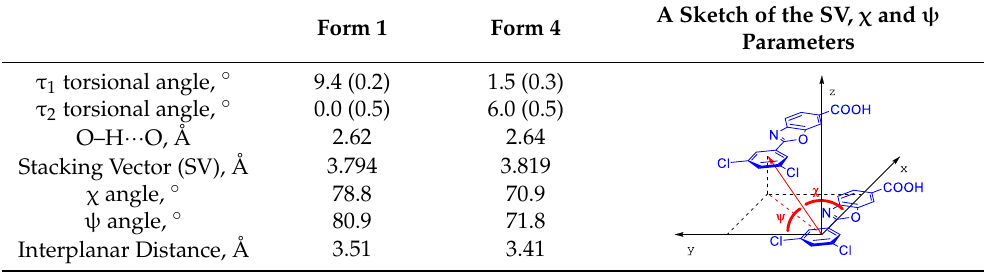
Table 2. Comparison of relevant stereochemical and geometrical parameters highlighting similarities and differences between the two polymorphic forms of Tafamidis. A Sketch of the SV, χ and ψ